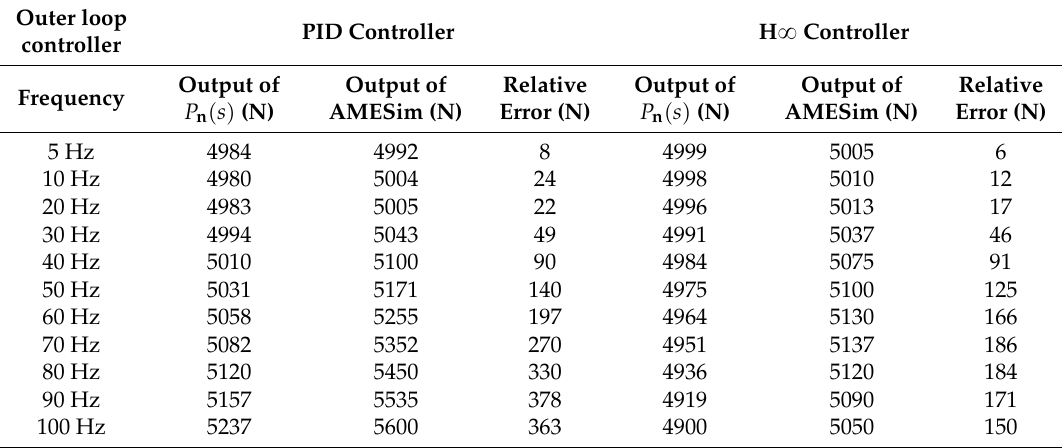
Table 3. Comparative results of different outer loop